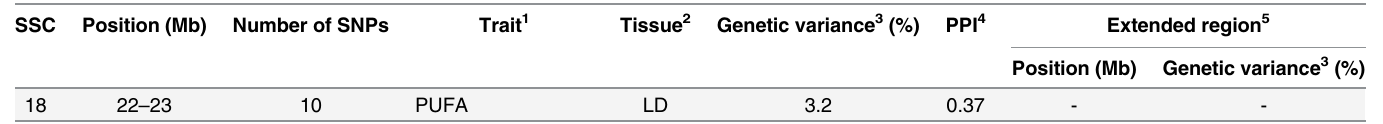
1 IMF: intramuscular fat content; SFA, MUFA, PUFA: saturated, monounsaturated, and polyunsaturated fatty acids; C18:1: oleic acid; C18:0: stearic acid; AdjIMF: trait with intramuscular fat content fi tted in the model as a covariate. 2 GM: muscle gluteus medius (n = 135); LD: muscle longissimus dorsi (n = 135); SF: subcutaneous fat (n = 112). 3 Posterior mean of the percentage of total genetic variance explained by the window. 4 Posterior probability of inclusion (non-zero genetic variance). The average PPI for the windows explaining less than 0.5% of genetic variance was 0.04. 5 To take account of potential linkage disequilibrium between SNPs, combinations of contiguous 1-Mb windows that explained at least 0.5% of genetic variance were considered. Regions that explained at least 2.5% of genetic variance are shown. * Below 2.5% but shown due to the importance of the